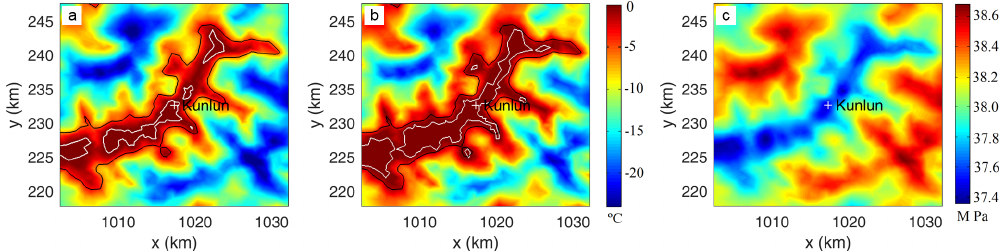
Figure 8. Basal temperature relative to pressure melting point using Kunlun fabric and a geothermal heat flux of 55 mWm − 2 (a) and 60 mWm − 2 (b) , and the hydraulic potential (c) . The bedrock areas at pressure-melting point in (a) and (b) are surrounded by a white contour. Kunlun station is marked as white plus sign. The black curve in (a) and (b) shows the outline of the valley defined as the 1500m contour in bedrock